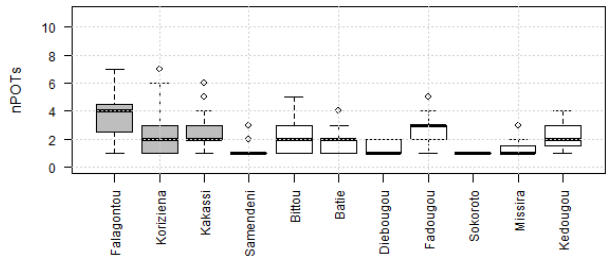
Figure 5. Boxplots for nPOT time series within the period 1970– 2010 summarizing the characteristics of the nPOT series used. The boxplot represents the median on the middle hinge and the 25th (75th) percentile on the lower (upper) hinge. The lower (upper) whisker is the border beyond which outliers are considered to be equal to 1 . 5 × interquartile range − 25th ( + 75th). Empty circles rep- resent outliers greater than the upper whisker or below the lower whisker. The three first boxes represent the time series for Sahelian